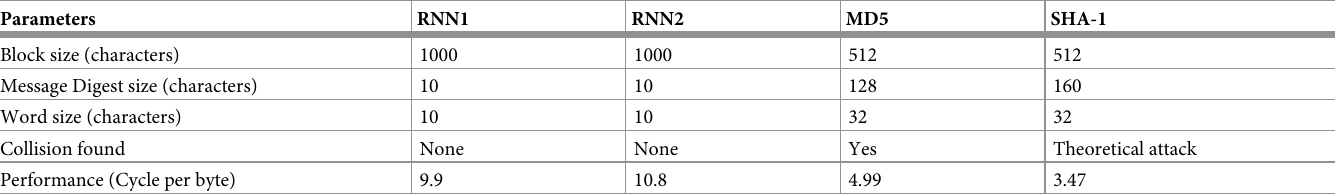
Table 1. The recurrent NN